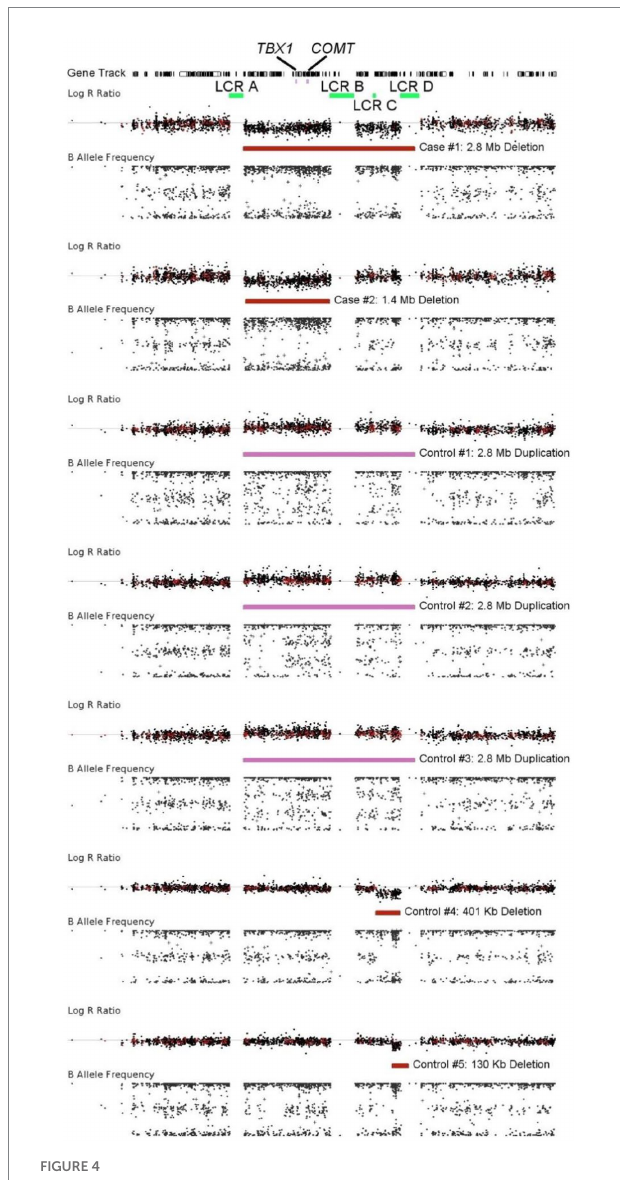
FIGURE 4 Visualization of a CNVs identified at the chromosome 22q11.2 region. The top panel for each individual depicts logR ratio data (signal intensity) and the bottom panel depicts the B-allele frequency (ratio of minor to major alleles). Dots indicate the location of probes on the array. The CNV calls were made using Genvisis and colored red for deletions and pink for duplications. These CNVs are thought to be created due to non-allelic homologous recombination at the low copy repeats (LCRs) in green. Most are between LCR A and LCR D, but the deletion in Case #2 is between LCR A and LCR B. The most critical genes causing the characteristics of 22q11.2 deletion syndrome are thought to be TBX1 and COMT . Duplications of this region are protective against